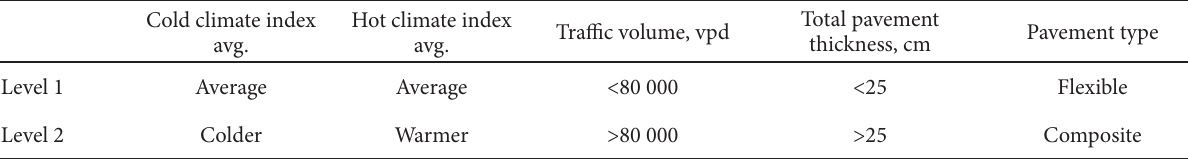
Table 2. Categorical binning of pavement